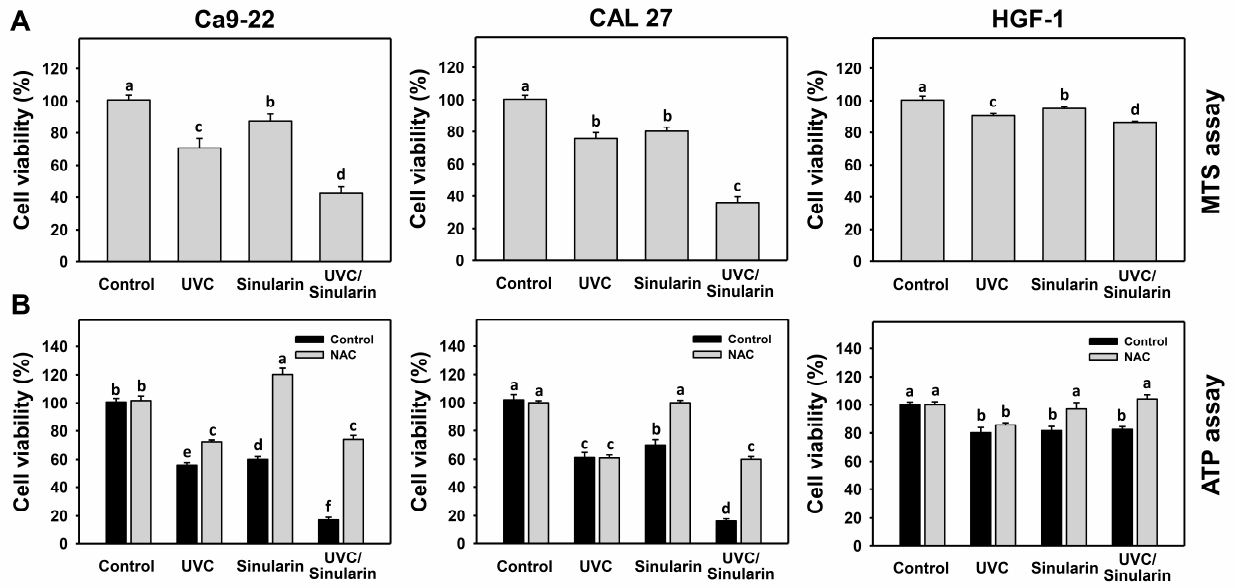
Figure 1. Cell viability for UVC and/or sinularin using MTS and ATP detections. Following the NAC preincubation (5 mM for 1 h) or not, the cells were arranged into four kinds of treatments: the control (0.1% DMSO in medium), UVC, sinularin, and UVC/sinularin for 48 h. UVC and/or sinularin conditions were 12 J/m 2 , 2 µ M and 10 J/m 2 , 3 µ M for oral cancer cells (Ca9-22, CAL 27), and 12 J/m 2 , 3 µ M for normal cells (HGF-1) for 48 h, respectively. Subsequently, the cell viability was detected by MTS and ATP assays. ( A ) MTS assay. ( B ) ATP assay. For multi-comparisons, the treatments marked